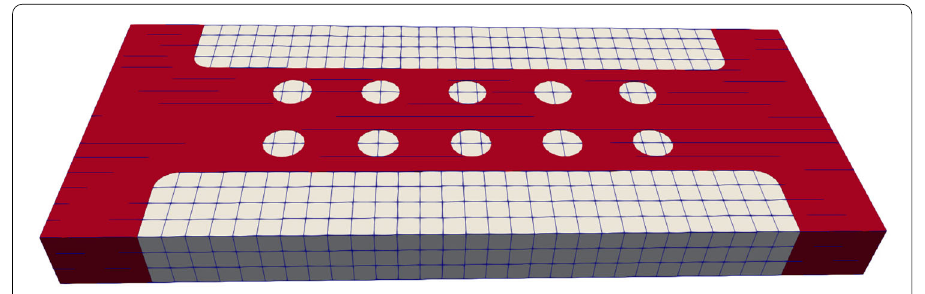
Fig. 8 Input tensor. Bounding box used to get a 3D image of a temperature field to be fed into DNNs